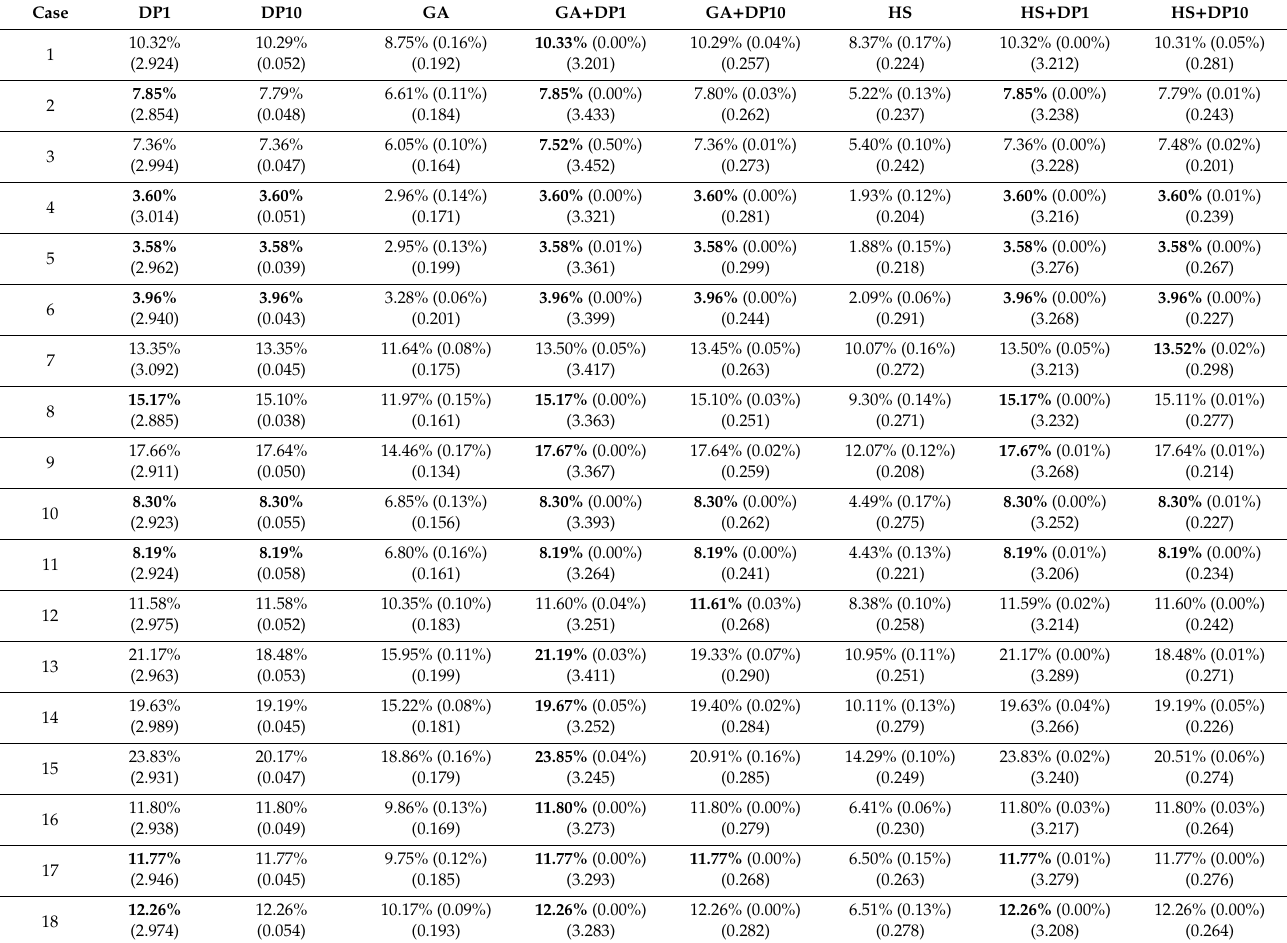
Table 3. Comparison of cost savings of the proposed methods without demand